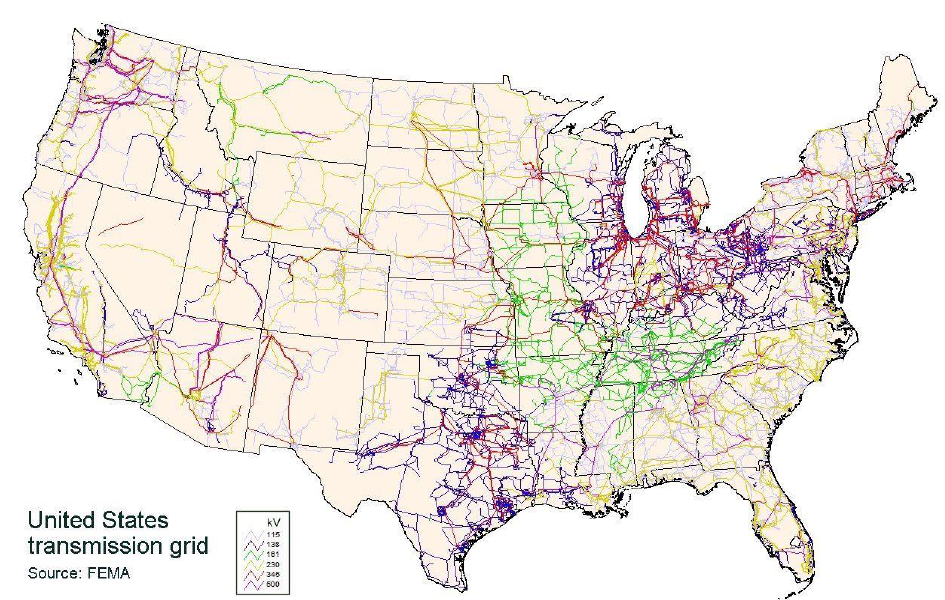
Figure 3. North American Electric Grid (Source: FEMA) (Source: https://en.wikipedia.org/wiki/North_American_Electric_Reliability_Corporation#/media/File:UnitedStatesPowerGrid.jpg,